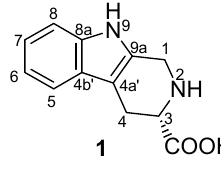
Figure 1. The structure of compound 1 .